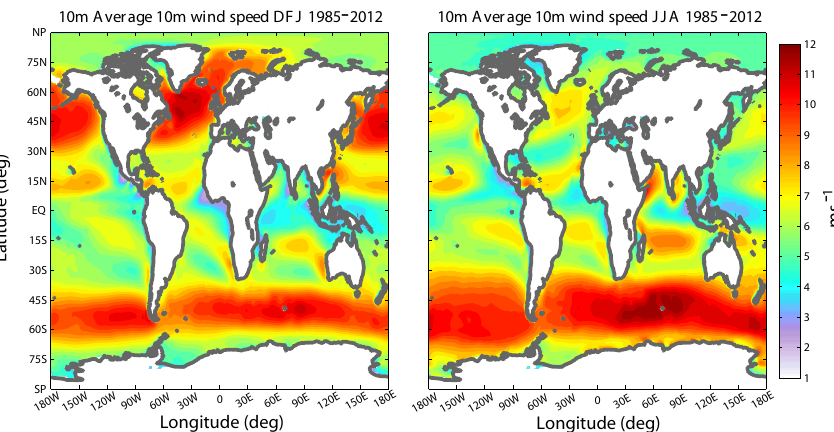
Fig. 3. December–February and June–August global 10m wind speed over oceans obtained from ECMWF ERA-40 and operational analysis, averaged between 1985 and